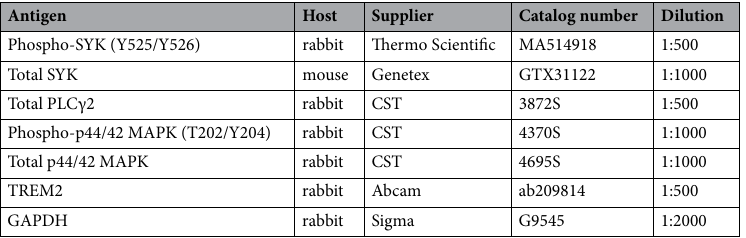
Table 1. Primary antibodies used for Western